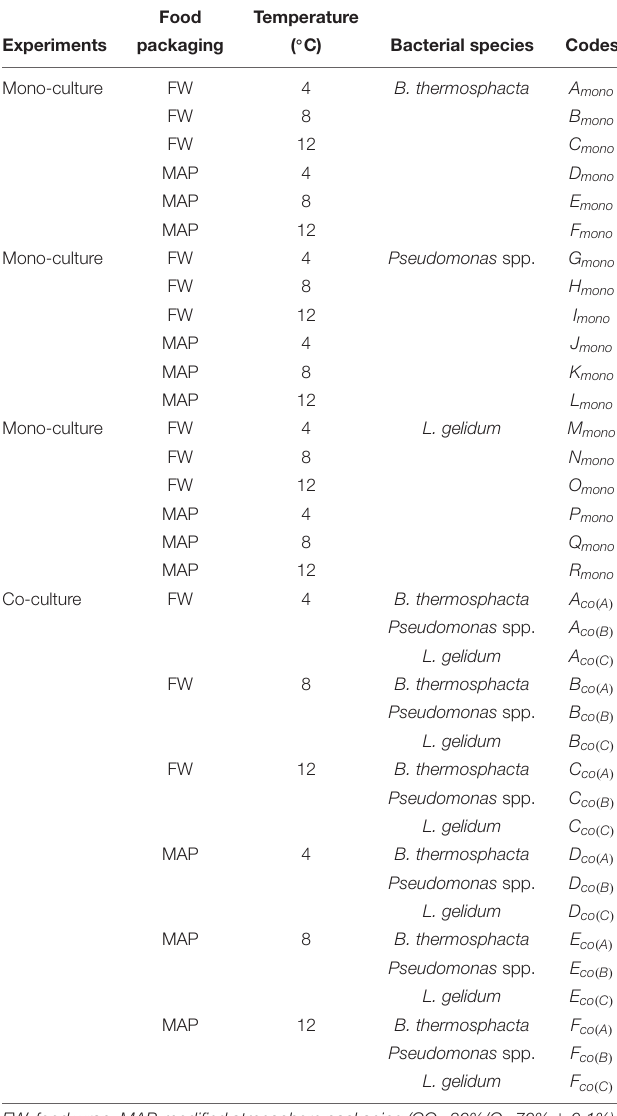
TABLE 1 | List of the codes used for the experiments, depending on the inoculated bacteria and storage conditions. Food Temperature